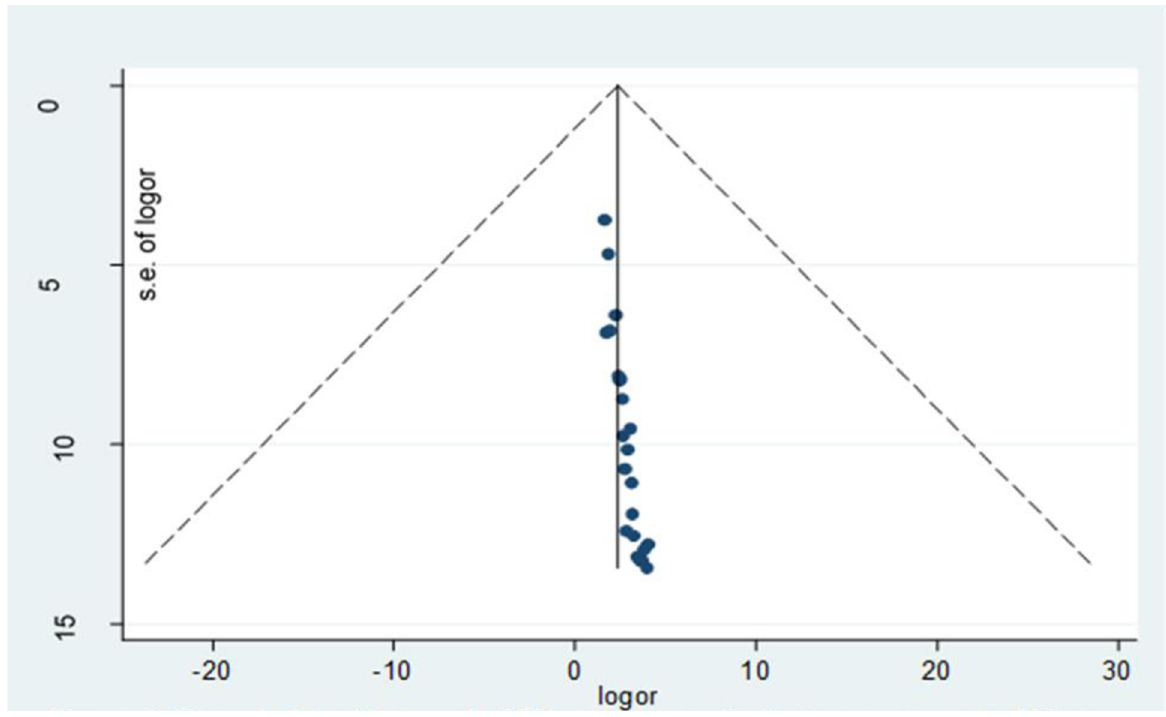
Fig 3. Funnel plot with pseudo 95% confidence limits for bias